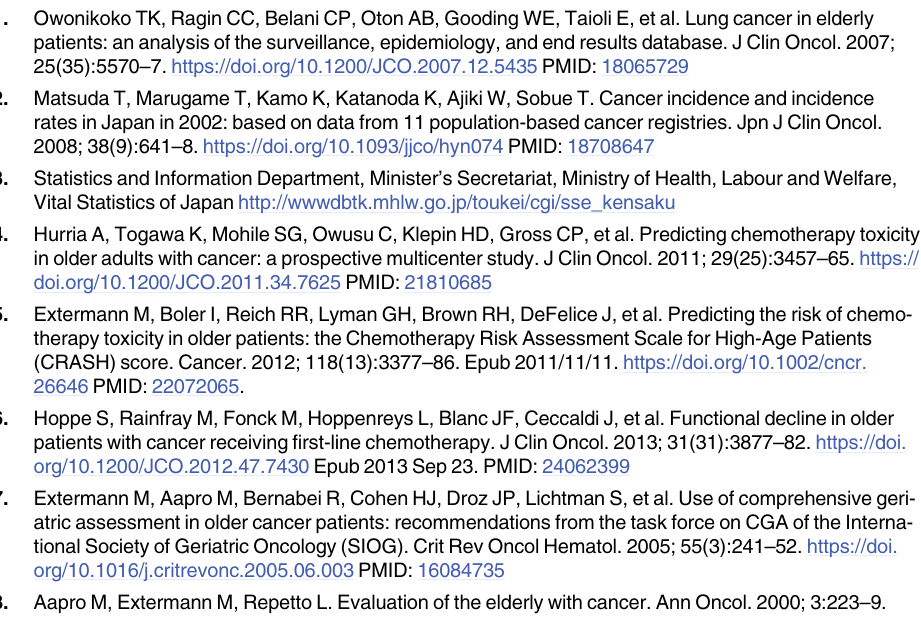
S1 Table. The G8 questionnaire. BMI, body mass